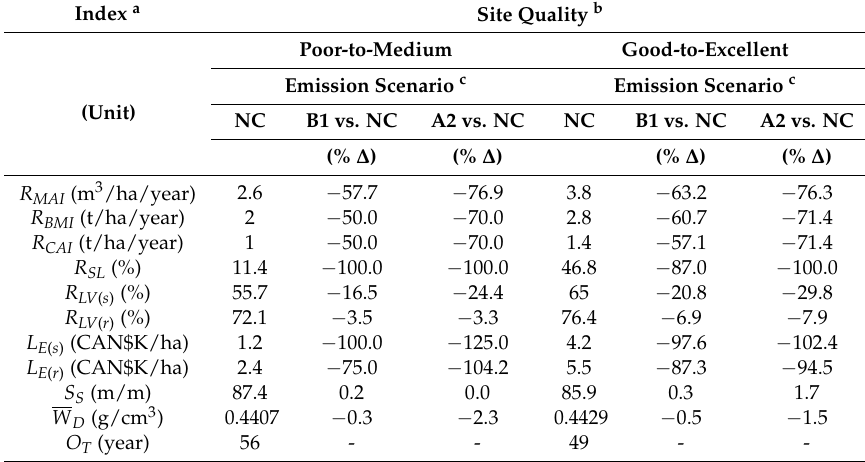
a–c : As defined in Table 3a table notes. Table 4c. Stand-level performance indices for jack pine plantations managed under a basic silvicultural intensity in north-western Ontario by emission scenario and site